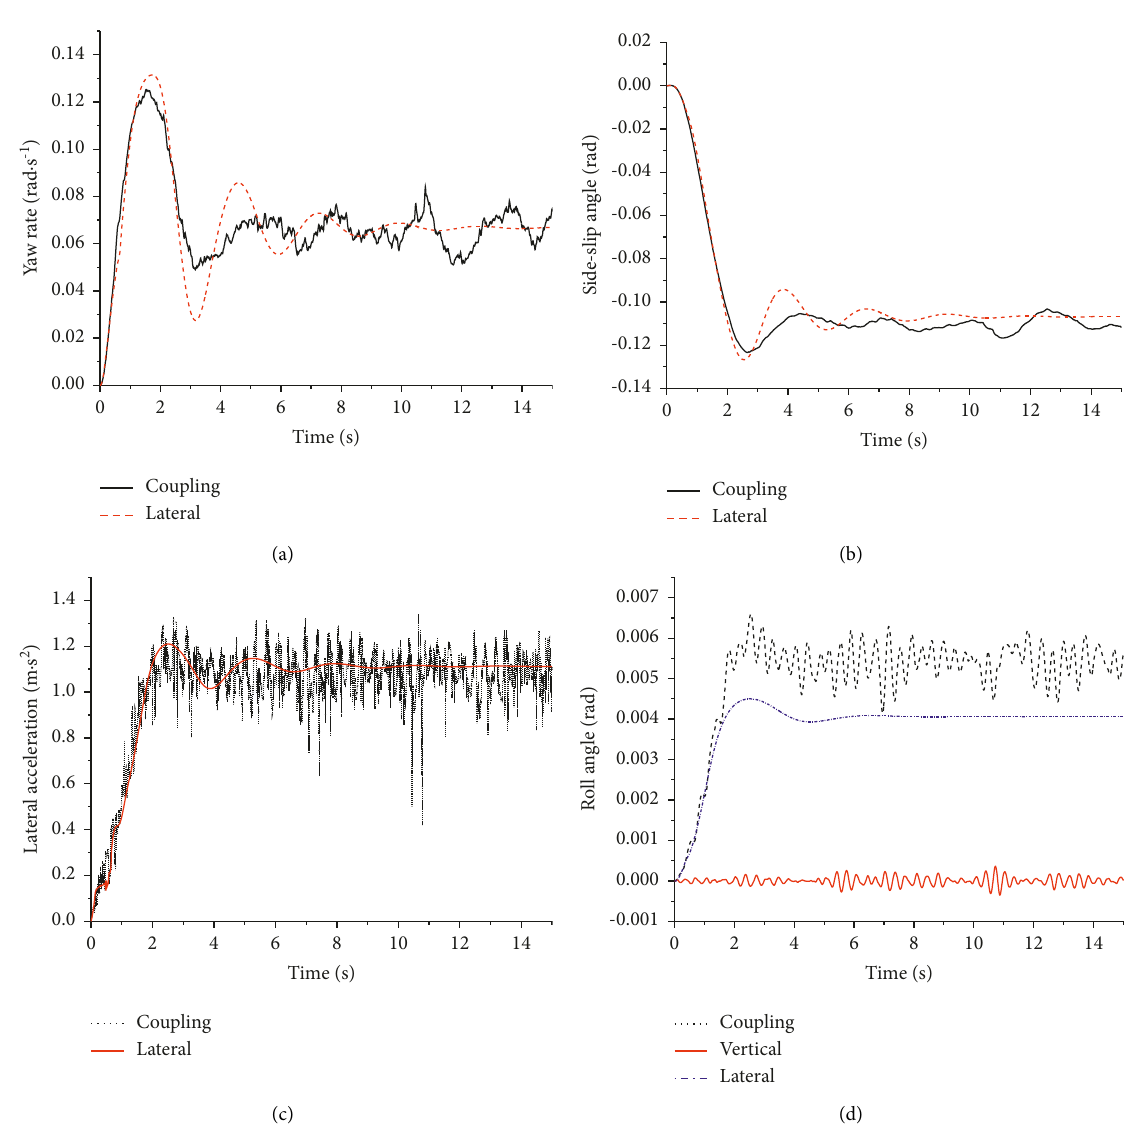
Figure 7: Handling stability (angular step condition, B-level random road). (a) Yaw rate. (b) Side-lip angle. (c) Lateral acceleration. (d) Roll